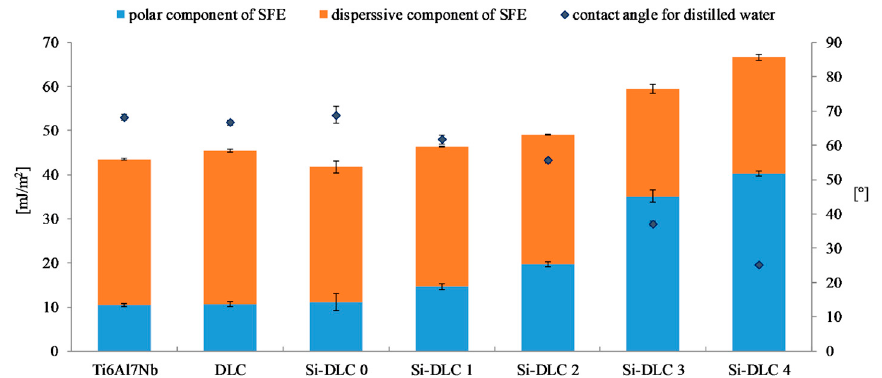
Figure 5. The Fourier transform infrared spectroscopy (FTIR) spectra of the deposited coatings Si-DLC coatings: ( A ) Si-DLC 4, ( B ) Si-DLC 3, ( C ) Si-DLC 2, ( D ) Si-DLC 1, ( E ) Si-DLC 0.